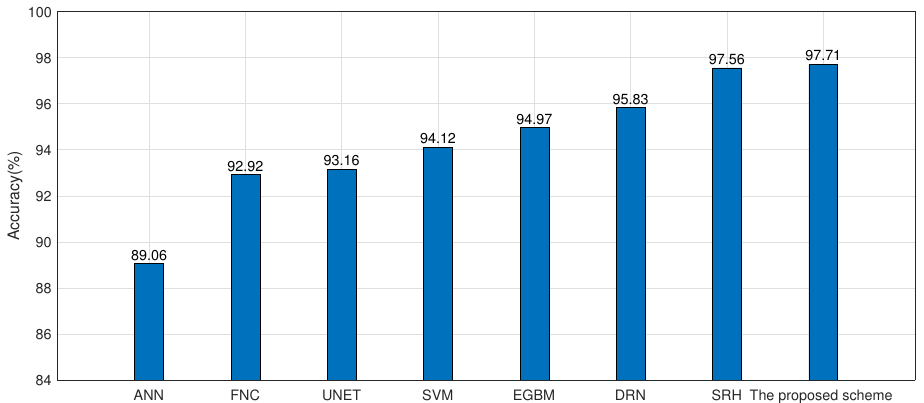
Figure 14. The comparison of accuracy using different methods in the UCI data set.